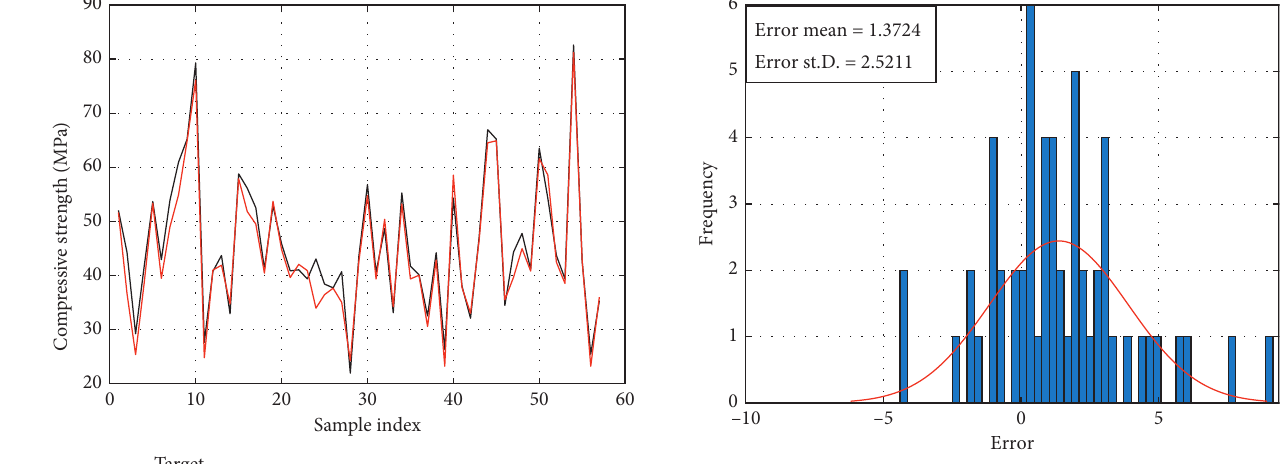
Figure 8: Histogram of error for the testing dataset and a fit corresponds to the distribution of error.